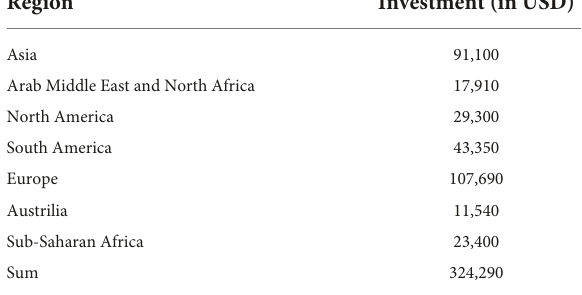
TABLE 1 Chinese OFDI by region between 2018 and 2021 (Heritage